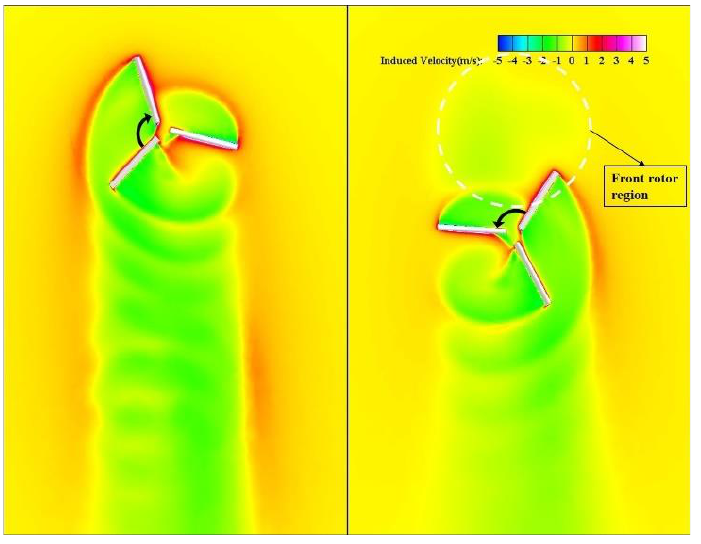
Figure 16. Roto-induced velocity field at V x = 15 m/s, θ = 10 deg , θ 0 = − 2